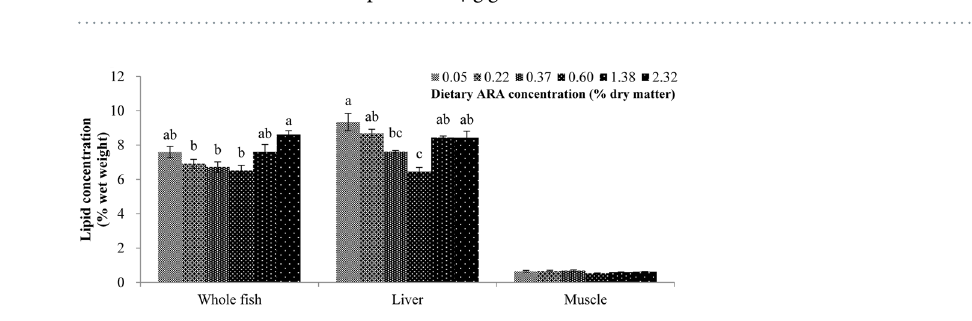
Figure 4. Hepatic protein concentration of selected proteins assayed with ELISA methods. ( a ) Lipid metabolism-related proteins; ( b ) Cell cycle-related proteins. Results are expressed as means ± standard error (n = 3). Different letters above the bars denote significant ( P < 0.05) differences among dietary groups. The concentration of SREBP1 was expressed as μ g g − 1 liver tissue.